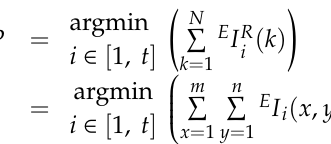
Figure 8. Diagram of the corresponding image in sparse matrix and mask offset.